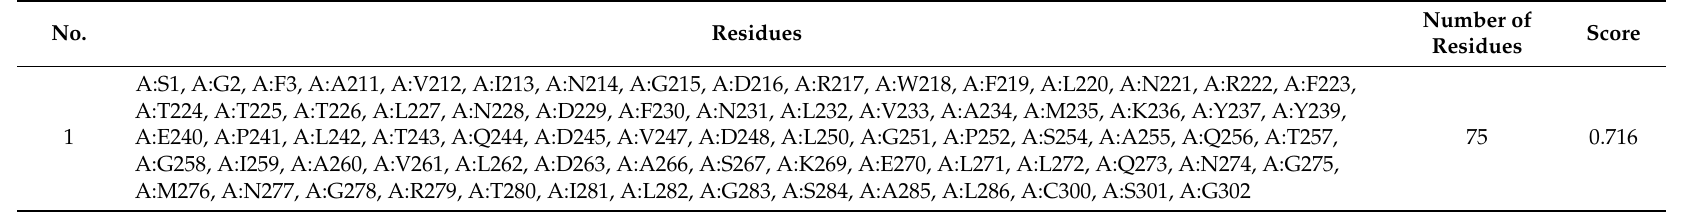
Table 9. Conformational epitopes of SARS-CoV-2 Mpro.